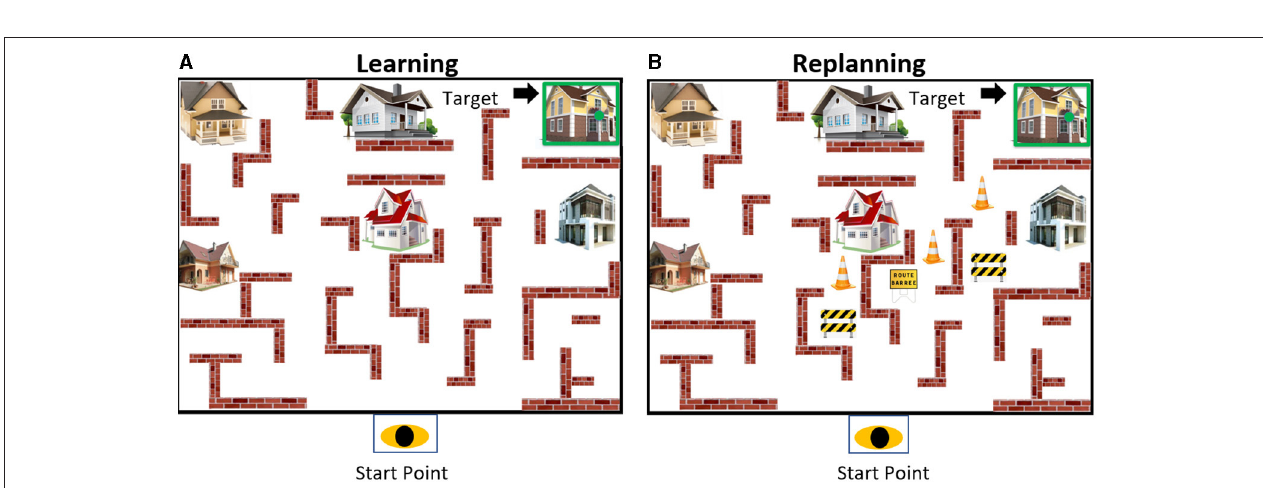
FIGURE 2 | The Virtual Maze layout. (A) The left image shows a target house highlighted in green. The same house was shown 5 times for inducing an overlearned trajectory. (B) The right image shows a target house highlighted in green and the obstacles blocking access to the house by the shortest paths. This induced the necessity to replan the overlearned